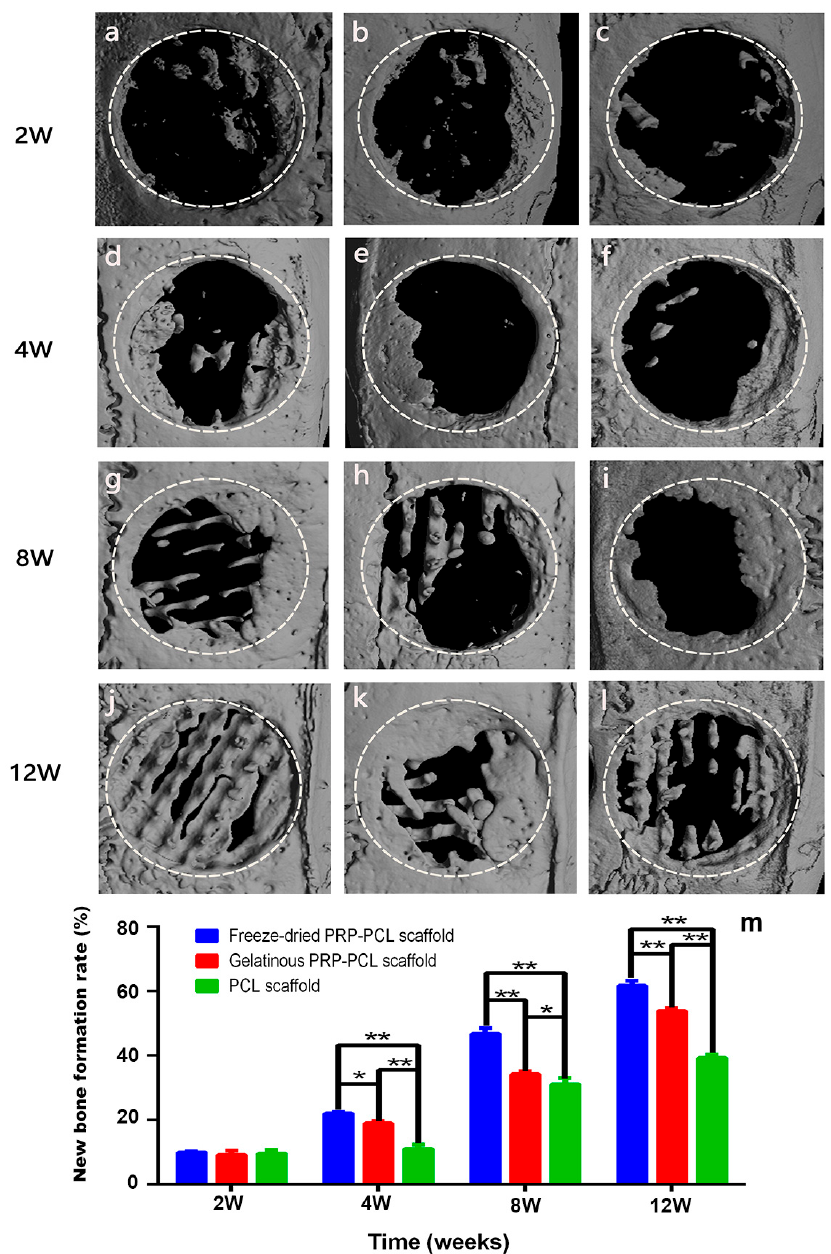
Figure 8. Evaluation of bone formation in calvarial defects via micro-CT. Representative micro-CT images of calvarial defects showing mineralized bone formation after treatment with freeze-dried PRP-PCL scaffolds ( a , d , g , j ), traditional PRP-PCL scaffolds ( b , e,h , k ) and bare PCL scaffolds ( c , f , i , l ). The bone tissue in the circle represents the regenerated bone. ( m ) Regenerated bone formation rate at 2, 4, 8 and 12 weeks after scaffold implantation (* p < 0.05, ** p < 0.01).